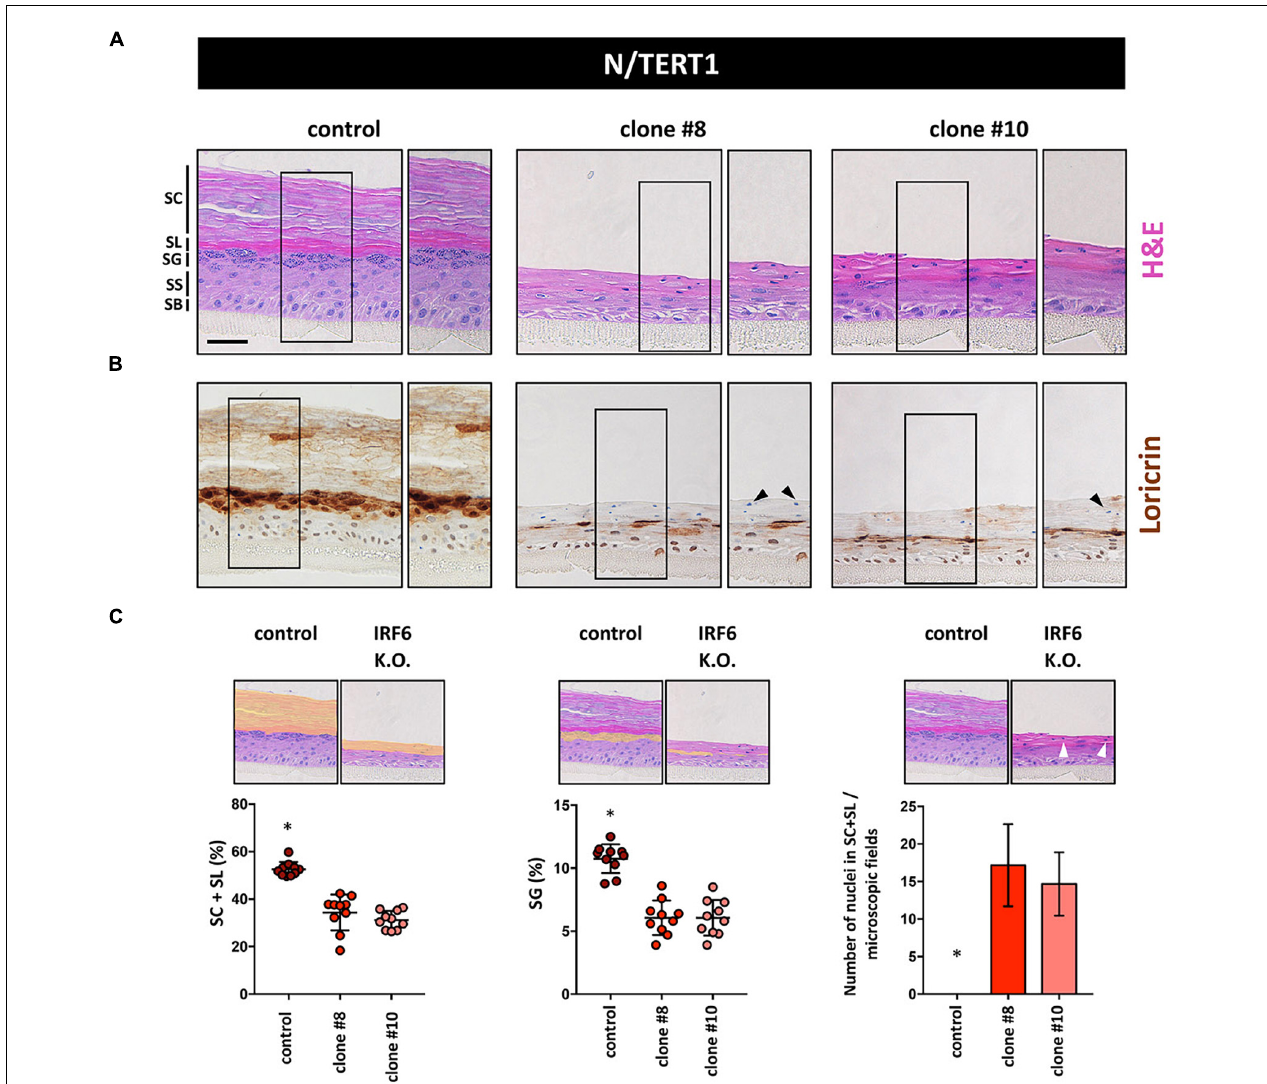
FIGURE 6 | (A) H&E staining of 3D skin organotypic cultures obtained with N/TERT1 control and N/TERT1 clones #8 and #10 keratinocytes. The various skin layers are indicated. SB: stratum basale; SS: stratum spinosum; SG: stratum granulosum; SL: stratum lucidum; SC: stratum corneum. Scale bar: 100 µ m. (B) Loricrin is strongly expressed in organotypic cultures of control keratinocytes in the stratum granulosum. In contrast, Loricrin is only weakly and irregularly expressed in the absence of IRF6. Close-up images are shown to the right of each organotypic culture. Arrowheads indicate aberrant presence of nuclei in the SC. (C) Quantification of H&E pictures of the 3D skin models. Note that in the absence of IRF6 the area of the SL + SC (orange area left panel), as well as the SG (orange area middle panel) are significantly reduced. Also, absence of IRF6 results in the presence of cell nuclei (arrowhead) in the SL and SC, which is not the case for control (right panel). ∗ p < 0.05 control vs. clones #8 and